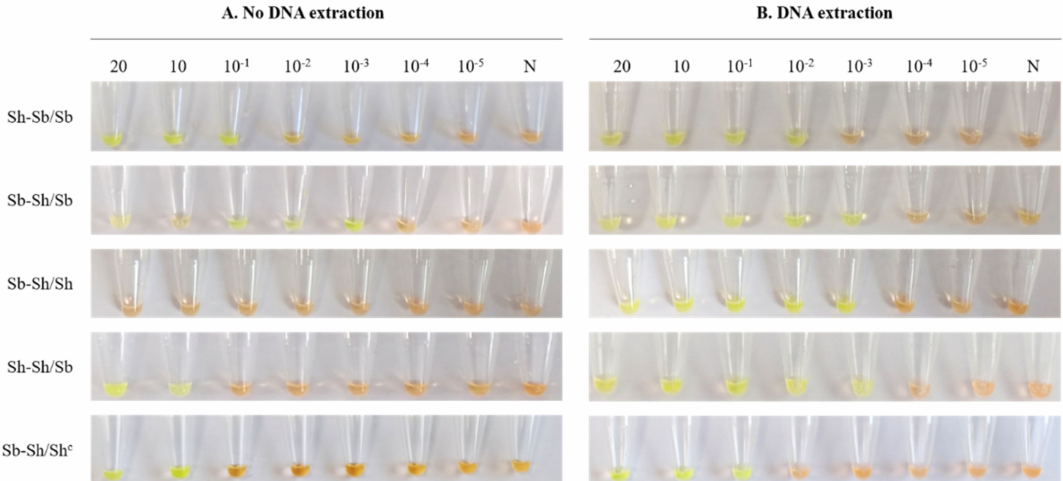
Figure 3. Sensitivity of the genus-specific LAMP assay in simulated human urine samples artificially spiked with gDNA from different hybrid schistosomes. ( A ) Sensitivity assessment of LAMP when performing a simple heating method from serial dilutions of hybrid schistosomes gDNA. ( B ) Sensitivity assessment of LAMP when performing the DNA extraction with the i-genomic Urine DNA Extraction Mini Kit (Intron Biotechnology, UK) from serial dilutions of hybrid schistosomes gDNA. Lanes 20, 10 and 10 − 1 –10 − 5 : 20 ng, 10 ng and 10-fold serial dilutions, respectively; Sh-Sb/Sb, Sb-Sh/Sb, Sb-Sh/Sh, Sh-Sh/Sb, and Sb-Sh/Sh c : gDNA from hybrid schistosomes; N: negative controls (no DNA